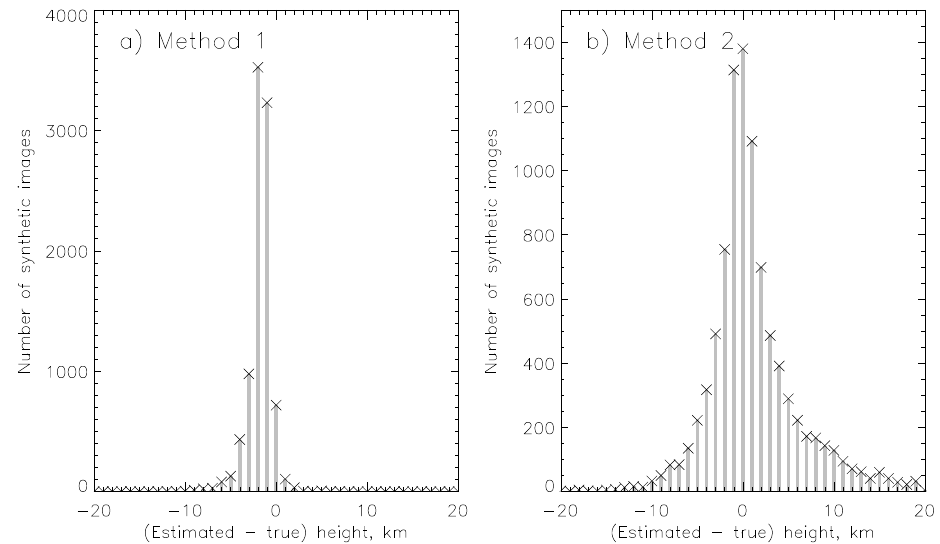
Fig. 8. Histograms showing the results from applying method 1 (a) and method 2 (b) to the set of synthetic images. Standard deviations: (a) 1.3, (b) 4.8.